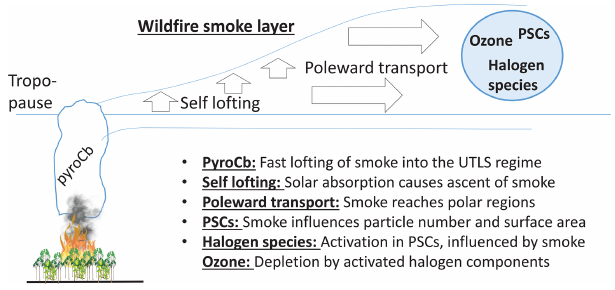
Figure 3. Key processes of the vertical and meridional transport of wildfire smoke from the emission sources to the polar